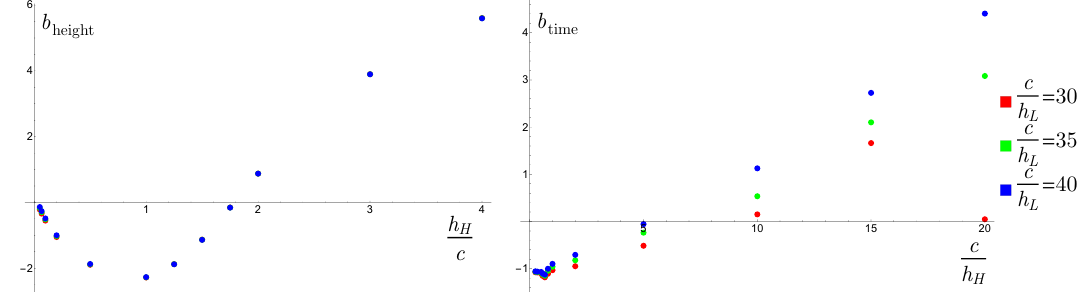
Figure 21 . We have found empirically that the time and height of the maxima of heavy-light Virasoro blocks have a simple dependence on both h and h H . This (cid:12)gure shows data on the parameters b height and b time de(cid:12)ned in equations (3.6) and (3.5). These plots both have c = 10. Each point is obtained from linear (cid:12)tting of data points at h explicitly that there is very little dependence on h L , especially at large values of h H